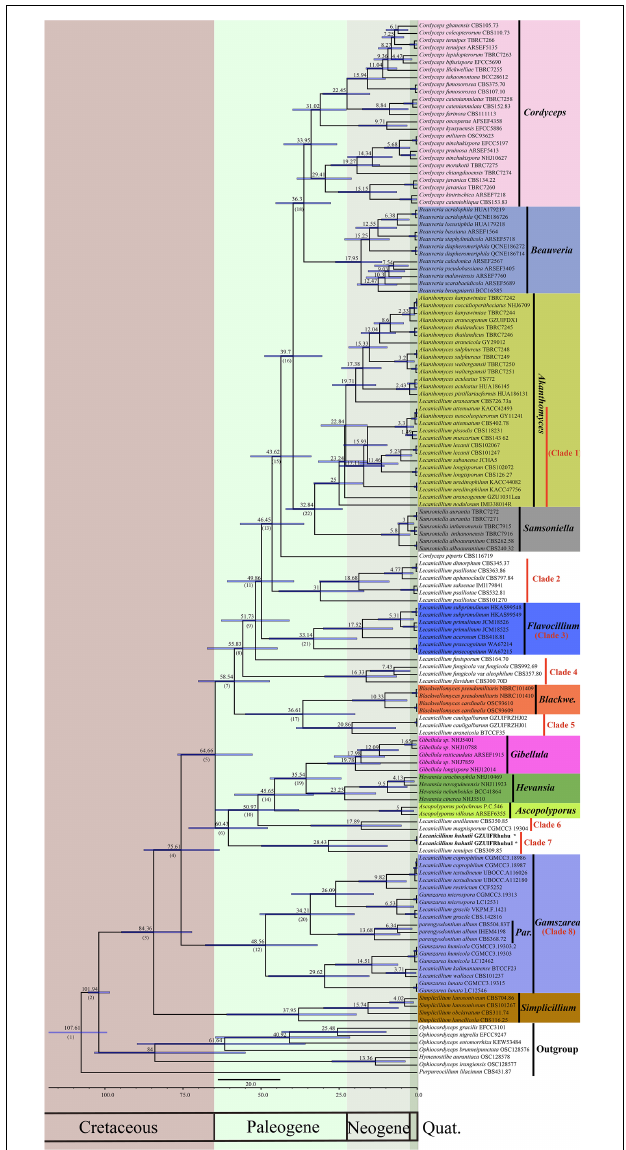
FIGURE 2 | Maximum clade credibility chronogram of Lecanicillium in Cordycipitaceae evolution. The chronogram results from the BEAST analysis are based on the topology of the ML tree. Each node represents the mean divergence time estimate (displayed above the nodes), while bars show the 95% HPD. Numbers corresponding to dated groups shown in Table 1 are indicated in square brackets above the nodes. The proposed novel species of the genus Lecanicillium is indicated in bold font and marked with